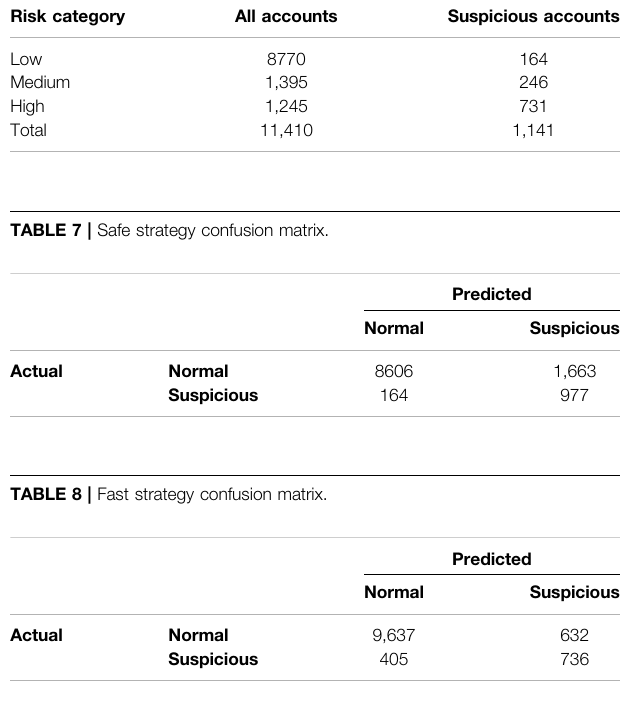
Inter-neural distance